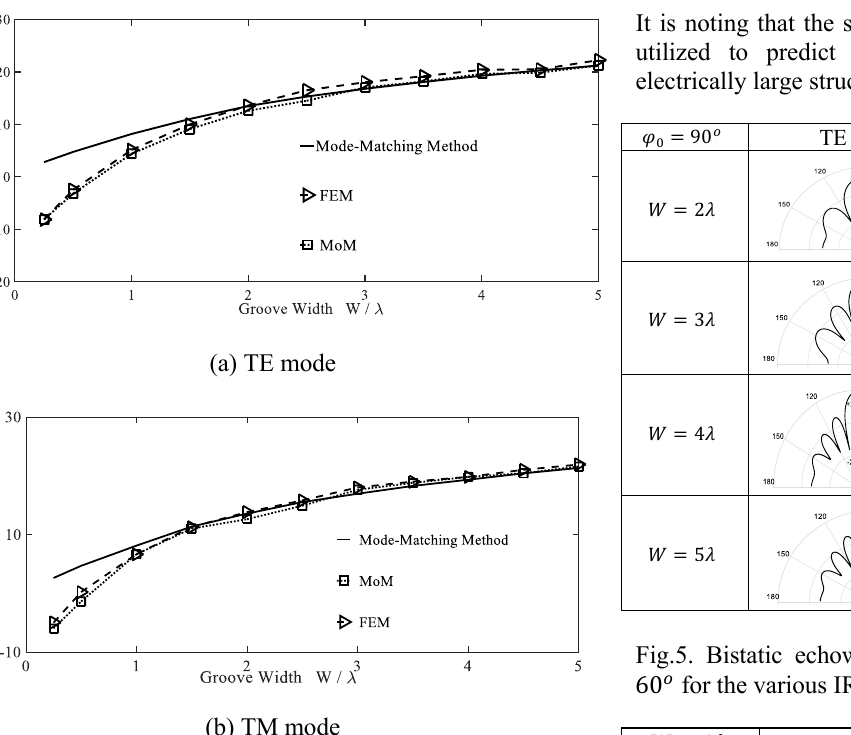
Fig.4. The echowidth of a dielectric-filled IRTG ( 𝜀 2.5 − 𝑗0.2 , 𝜇 = 1.8 − 𝑗0.1 and 𝜀 Q# normal incidence angle for various groove widths. (a) TE mode, (b) TM mode.